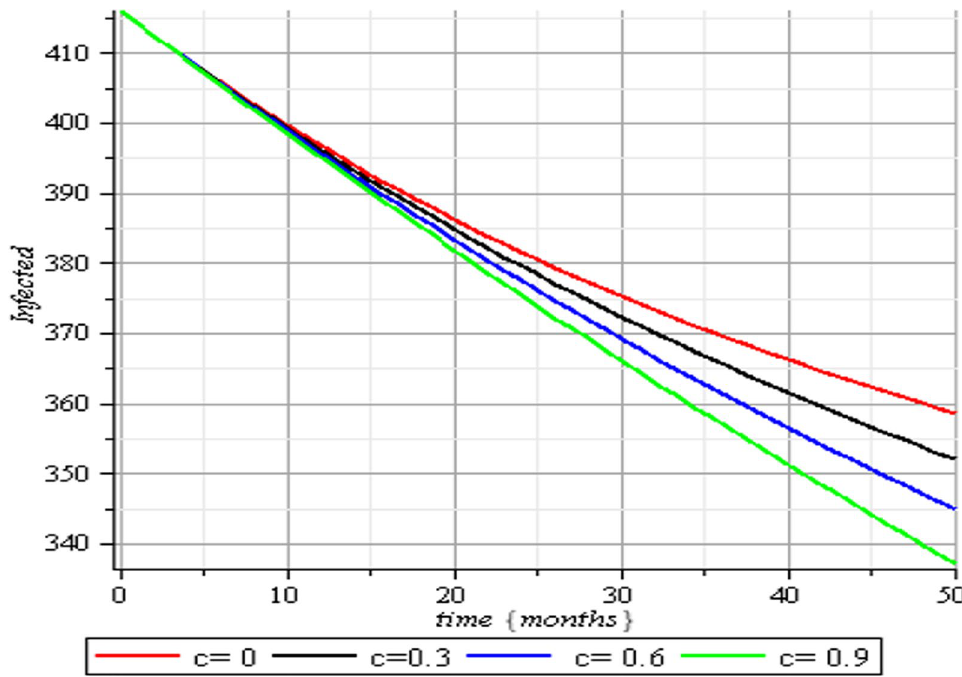
Fig. 4 Effects of human submission to physical limitation on the infected class